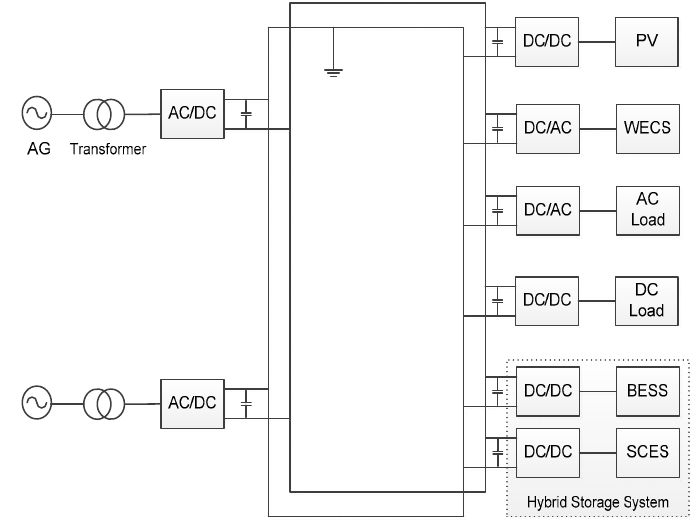
Figure 1. Typical loop configuration of the DC micro-distribution grid.